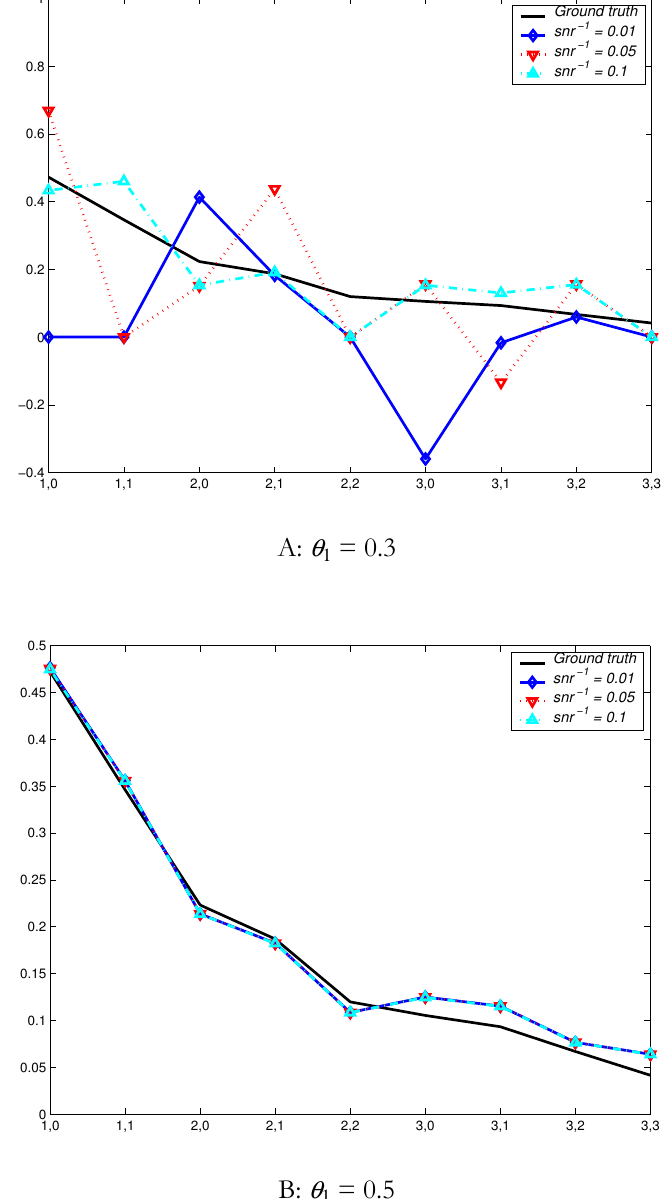
Figure 4 – Corrected correlation estimates for various values of location and attribute error parame- and snr ), under model (11), for the weak dependency case ( β = 0.75 in equation (12)). Cor- ters ( θ 1 relations are reported in the graph for spatial lags ( k , h ), k , h = 0, ..., 3, when snr –1 =0.01, 0.05, 0.1, θ = 0.5 (Plot = 0.3 (Plot A), and θ 1